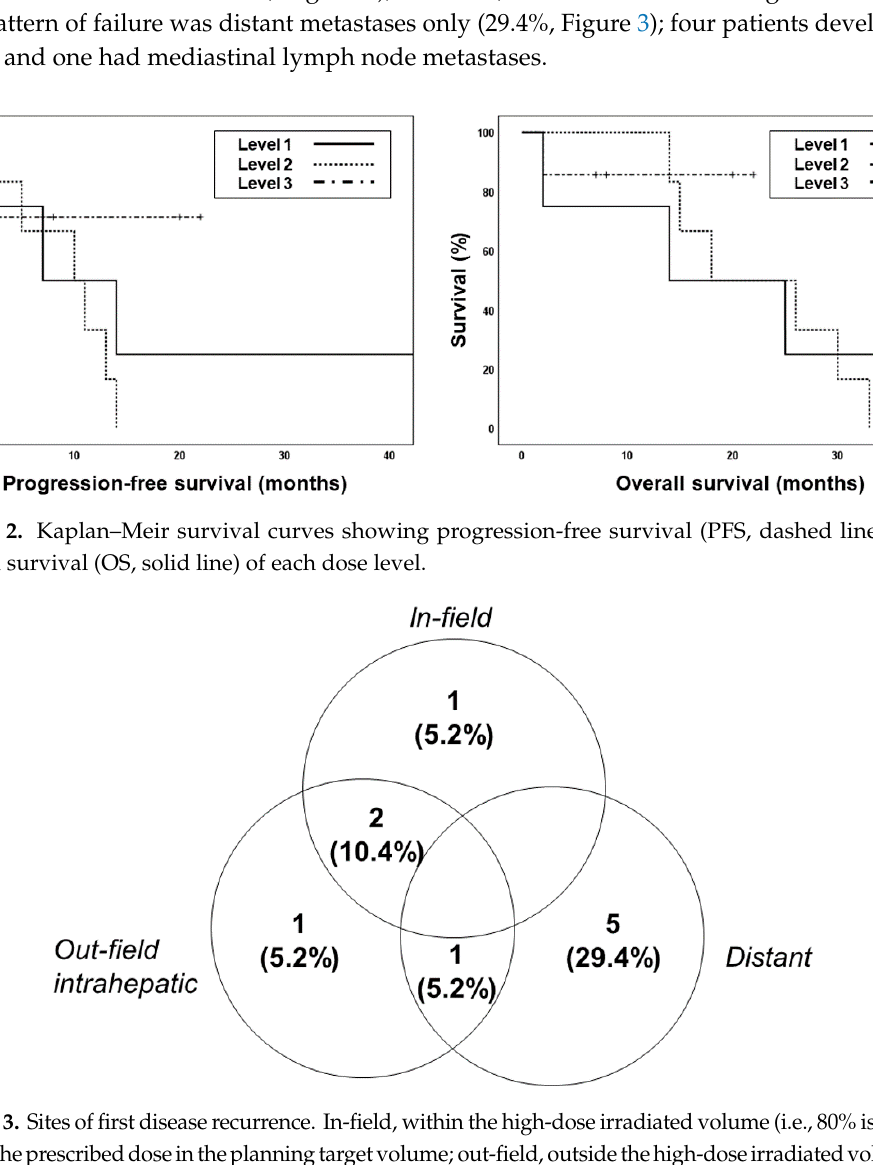
Figure 3. Sites of first disease recurrence. In-field, within the high-dose irradiated volume (i.e., 80% isodose line of the prescribed dose in the planning target volume; out-field, outside the high-dose irradiated volume).